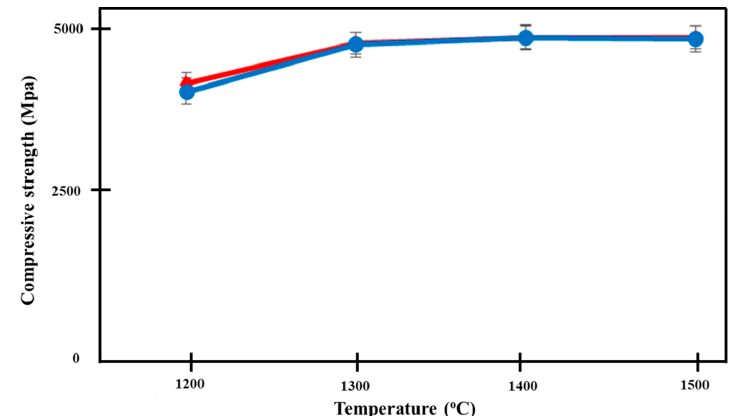
Figure 10. Compressive strength of Ca-SZ(CS); red line and Ca-SZ(CC); blue line when sintered for 2 h at different temperatures of 1200, 1300, 1400 and 1500 °